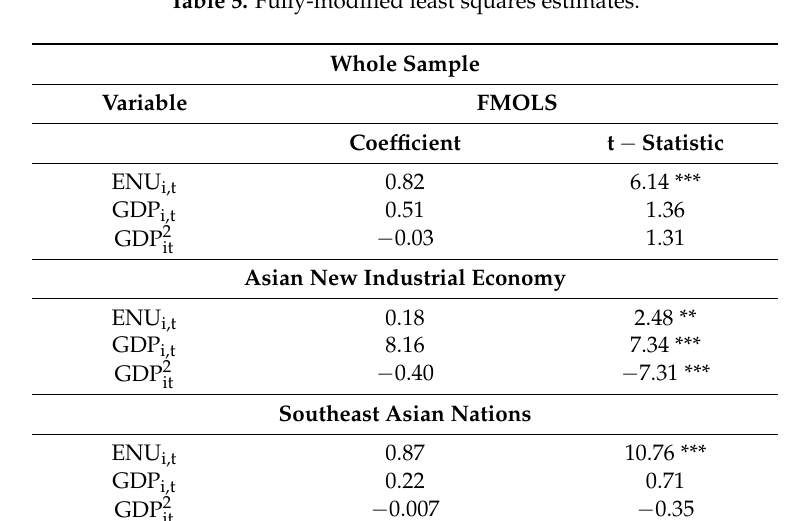
Table 5. Fully-modified least squares